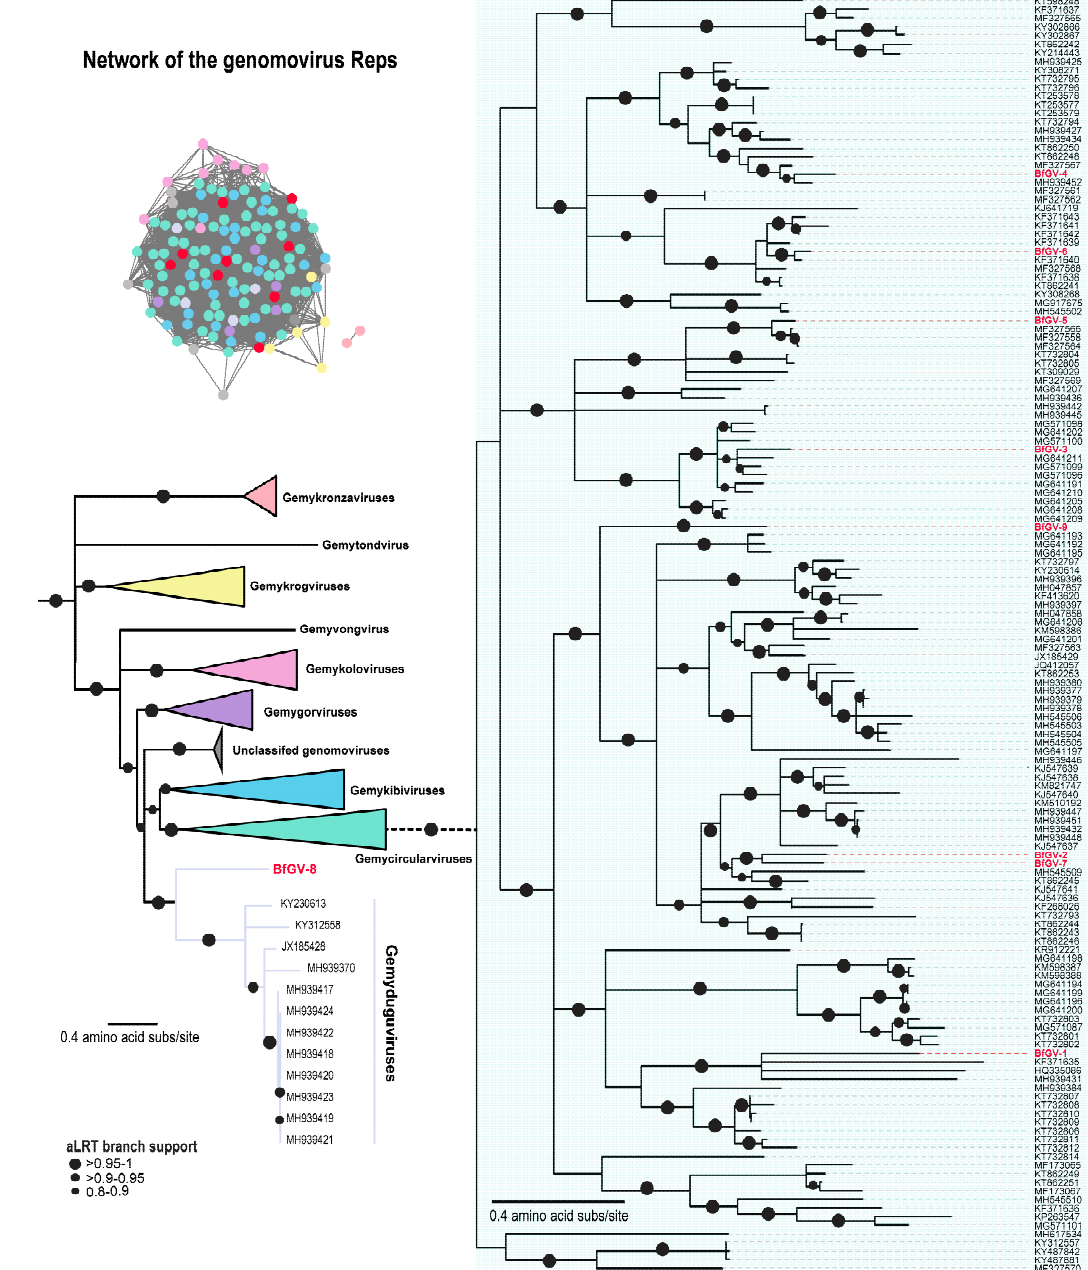
Figure 2. Network and phylogenetic analysis of the Rep sequences of genomovirus, each genus with a corresponding colour and blackfly originating genomoviruses shown in